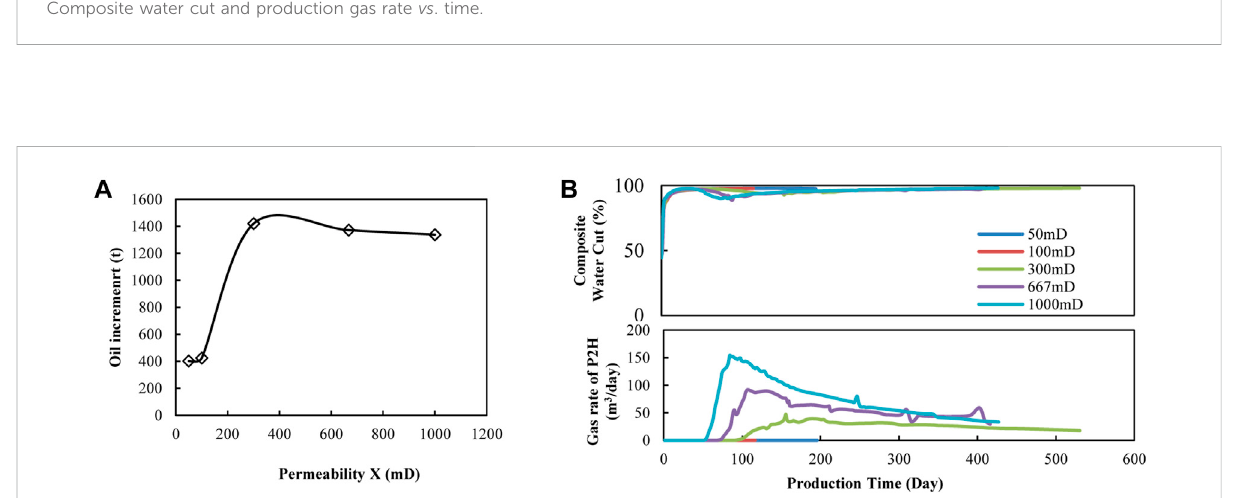
FIGURE 13 Production performance of different horizontal permeabilities for the well-to-well interplay of CO 2 huff-n-puff. (A) Oil increase vs . interwell spacing. (B) Composite water cut and production gas rate vs .